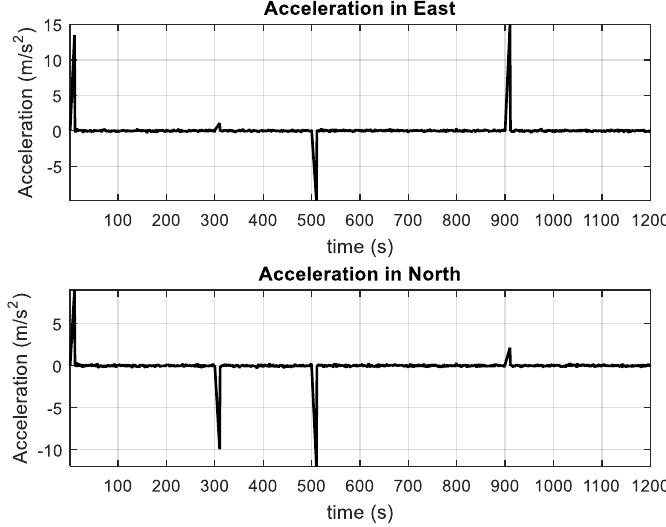
Figure 1. The accelerations involved in the simulated vehicle trajectory.